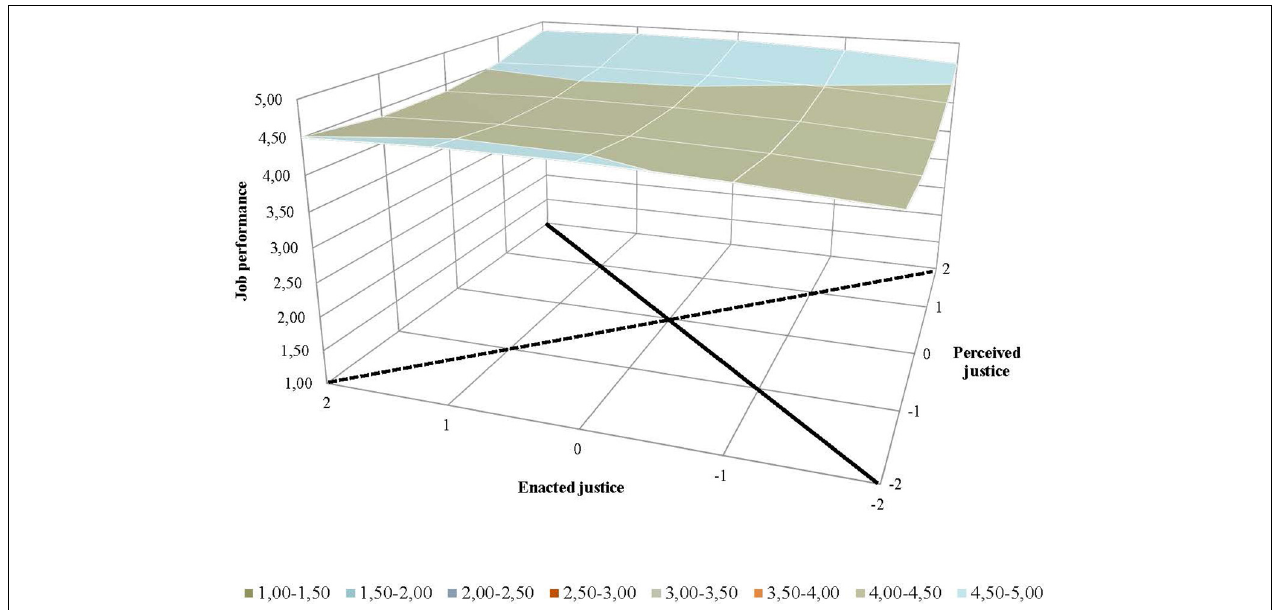
FIGURE 5 | Effects of (in)congruence between employees’ perceived pay justice and supervisors’ enacted pay justice on employees’ job